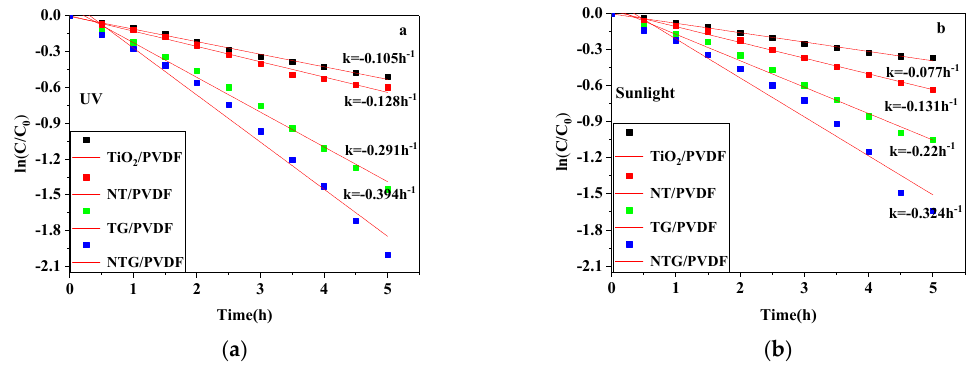
Figure 10. The MB photodegradation kinetics curves under ( a ) ultraviolet light and ( b ) sunlight.